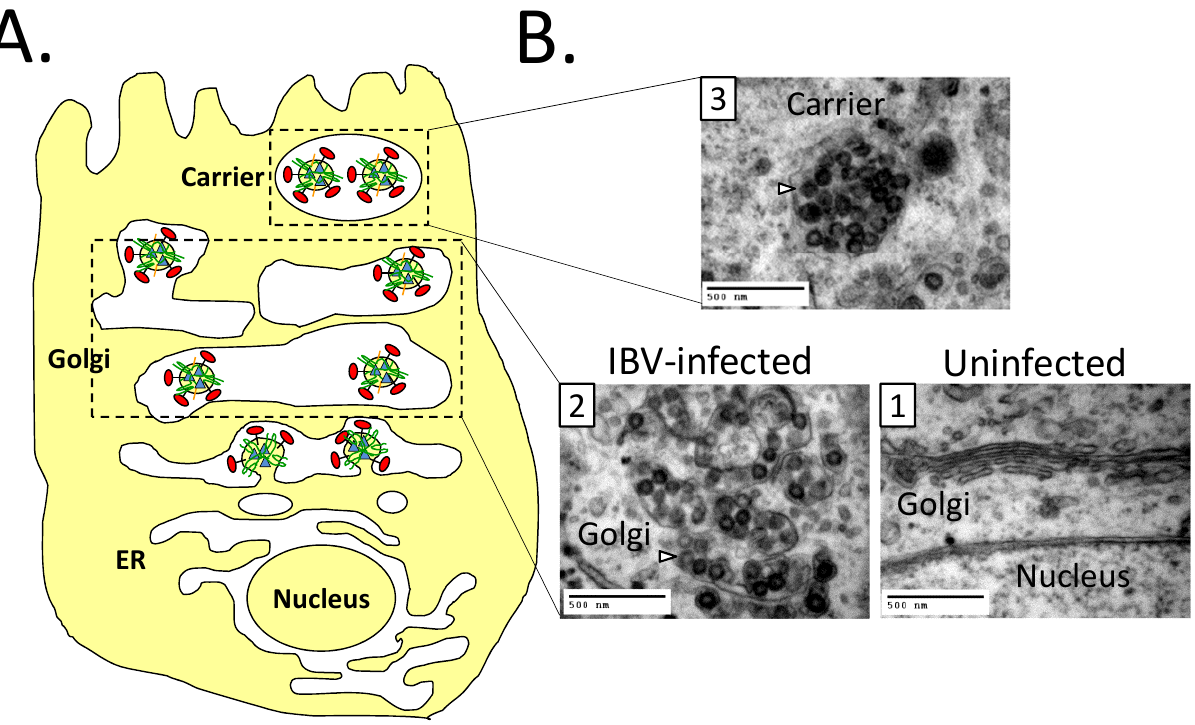
Figure 3. CoVs use the secretory pathway for egress. ( A ) A cartoon depicting virions within the Golgi complex. The Golgi cisternae are enlarged and fragmented during infection, possibly to aid in the trafficking of virions. ( B ) Transmission electron micrographs of uninfected or IBV infected Vero cells. (1) The Golgi complex of an uninfected cell; (2) The Golgi complex of an IBV infected cell with enlarged Golgi cisternae; (3) A putative virion carrier. Arrows denote virions. Scale bar is 500 nm. For images (2) and (3) Vero cells were infected at an moi of 0.1, and samples were fixed and processed 14 hrs post infection as described in